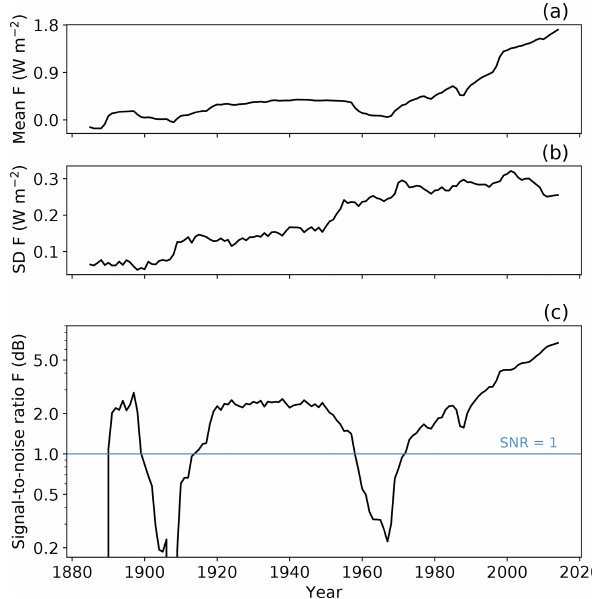
Figure 1. Effective radiative forcing over the historical period, cal- culated from 22 CMIP6 models as F = (cid:49)N + λ(cid:49)T : (a) ensemble mean; (b) ensemble standard deviation; (c) signal-to-noise ratio. Model means are calculated first, and then the ensemble mean is